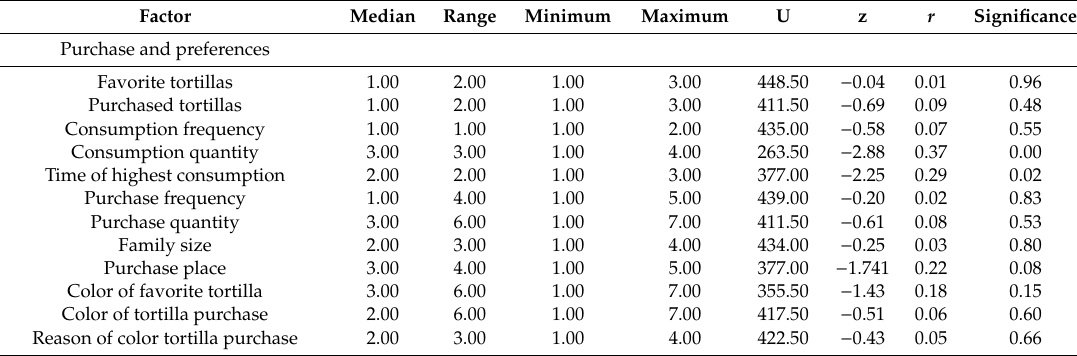
Table 4. Mann–Whitney test results for the female and male group comparison regarding tortilla preferences and purchase